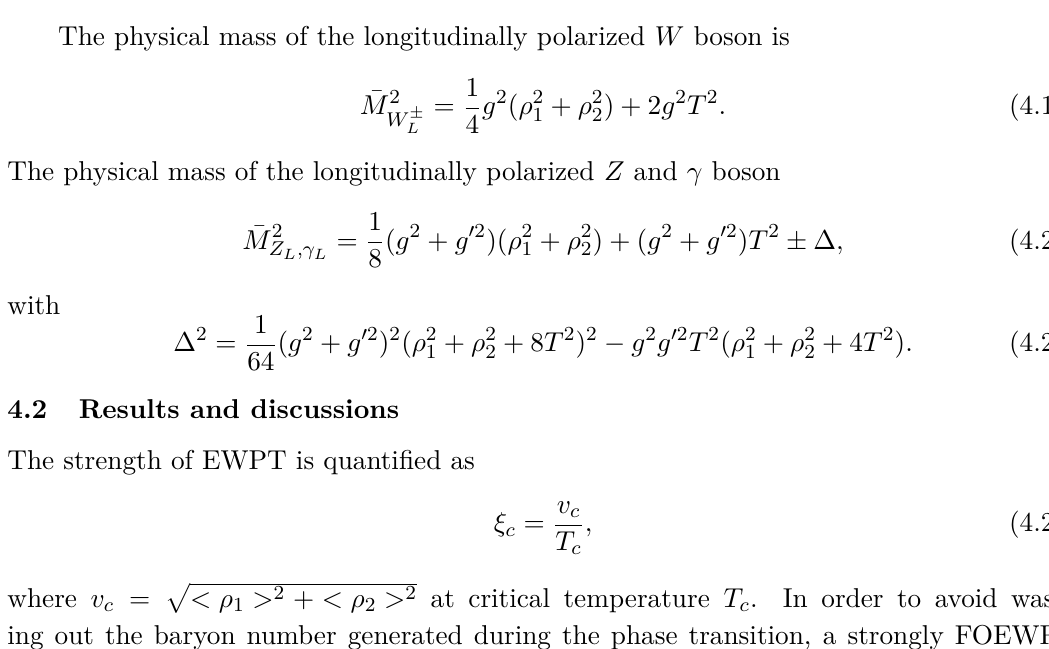
Figure 11 . In the type-I and type-II models, scatter plots of v c /T c and m H achieving the FOEWPT, h 2 -inflation or h 1 -inflation and satisfying various relevant theoretical and experimental